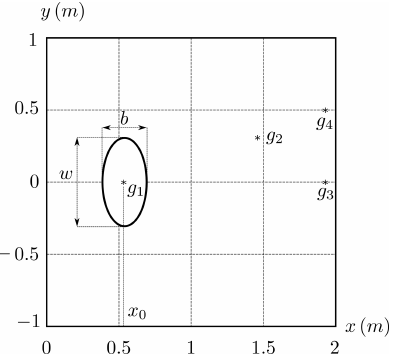
Figure 6. BP2. Sketch of the plan view (case 61mm) (from Kirby et al., 2018). Table 3. Gauge positions in dimensional and non-dimensional